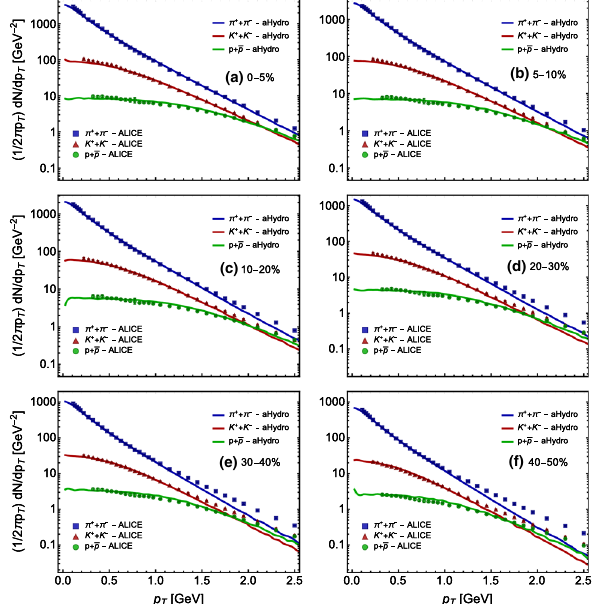
Fig. 2 Combined transverse momentum spectra of pions, kaons and protons for 5.02 TeV Pb–Pb collisions in different centrality classes. The solid lines are the predictions of 3+1D aHydroQP and the points are experimental results from the ALICE Collaboration [69]